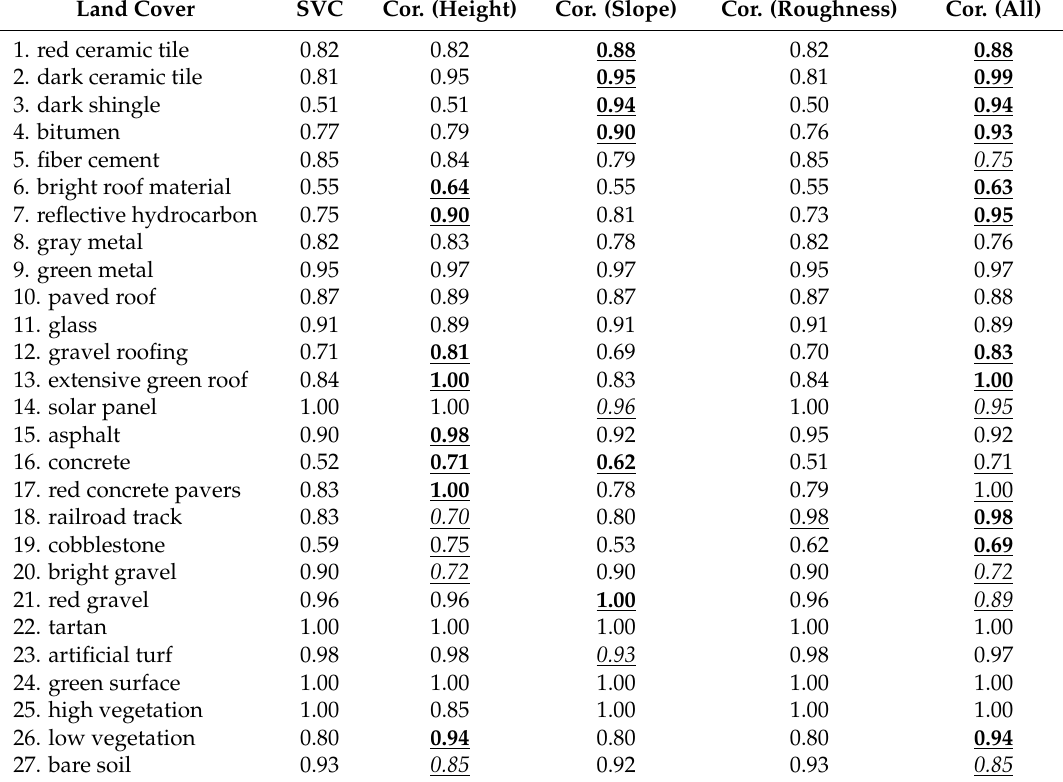
Table 3. Conditional kappas of level 2 sunlit land cover classes for Support Vector Classification and for each LiDAR post-classification correction. Bold underlined values indicate significantly higher and italic underlined values indicate significantly lower conditional kappas (z = 0.05) compared to SVC before correction. Note that level 2 land cover numbering of Table 1 has also been used in this table.